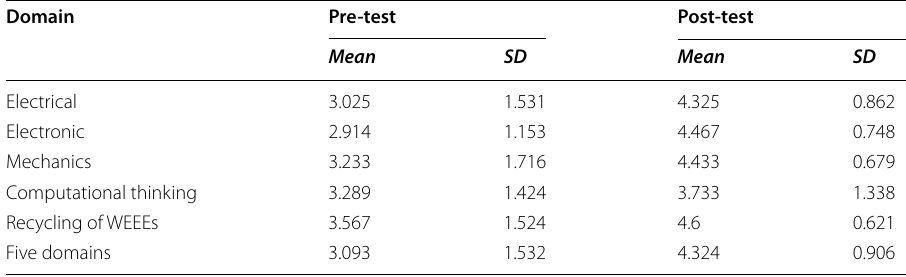
Table 3 Descriptive statistics (mean, standard deviation) of pre and post‑survey about the knowledge and STEM skills in the domains: Electrical, Electronics, Mechanics, Computational Thinking, and recycling of